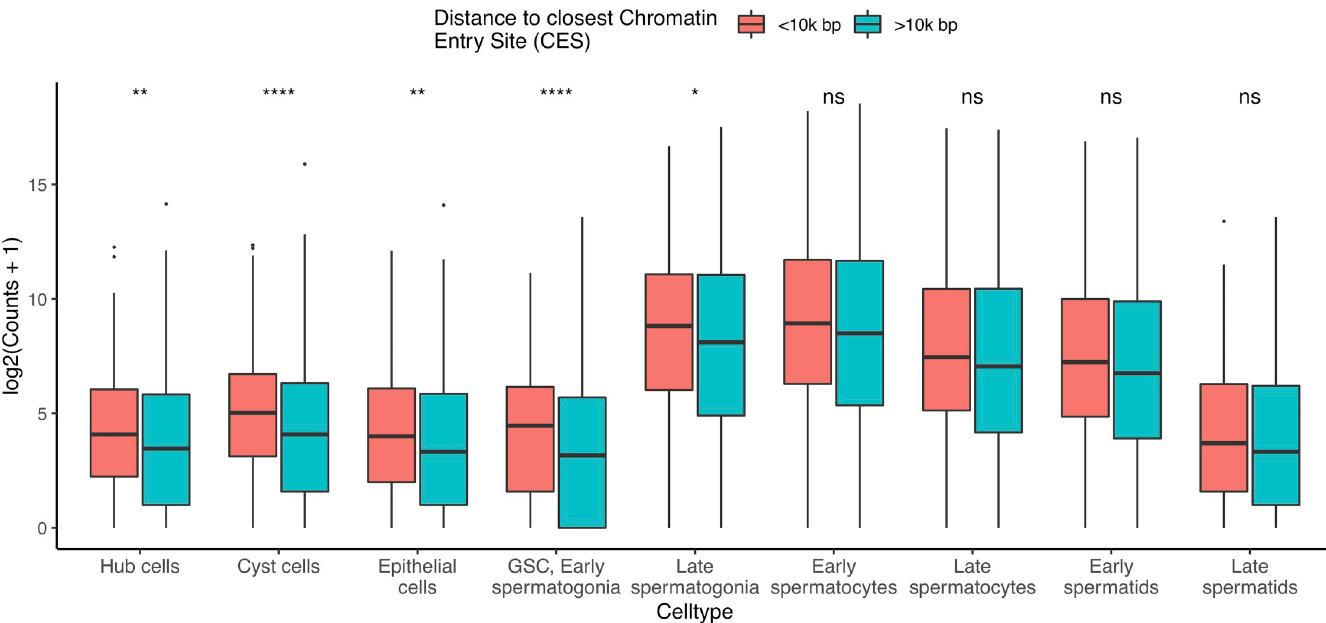
Fig 3. Close MSL CES correlates with increased transcription of X chromosome genes in cell types experiencing dosage compensation. The Y axis is log- transformed sum of counts for a given X chromosome gene in a cell type, grouped by proximity to a CES. Genes within 10,000 bp of a CES have statistically enriched expression compared to genes outside this range in all somatic cell types, and pre-meiotic germ cells (p values for two-tailed Wilcoxon test in Table 2). These are the same cell types with statistically similar X and autosomal expression in Fig 2. This indicates that the DCC is active in these cell types. Asterisks represent Holm-corrected p values as follows: ns: > 0.05, � < 0.05, �� < 0.005, ��� < 0.0005, ���� < 0.00005.